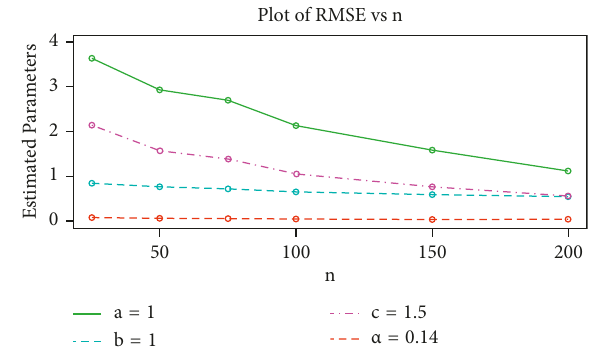
Figure 8: The plots of RMSEs for the ExEW parameters in set